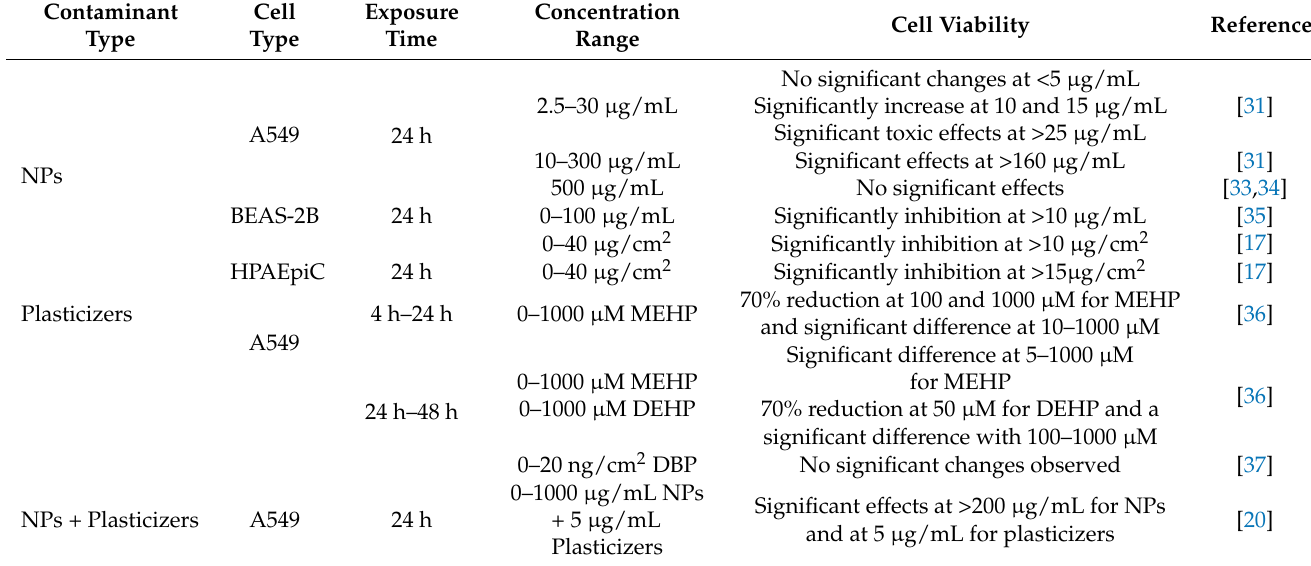
Table 3. Cell viability effects by concentration range and contaminant (NPs, plasticizers or